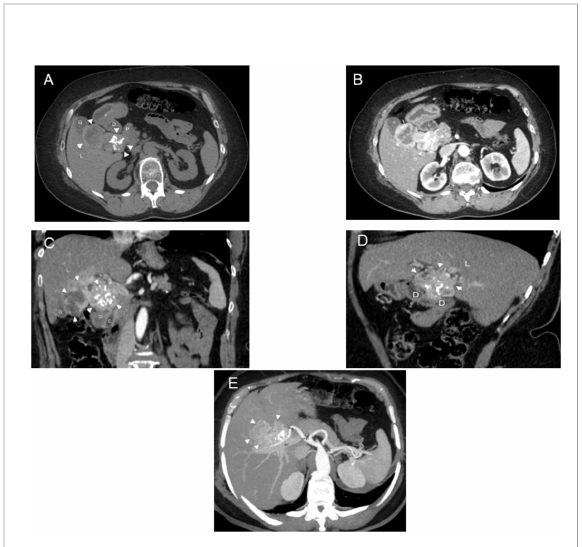
FIGURE 1 CT in a 65-year-old woman with ectopic thyroid in the hepatic hilum. (A) Unenhanced and (B) enhanced axial CT images. Dishomogeneous density and partially calci fi ed mass (arrowheads) can be observed in the right hypochondrium between the duodenum (D), liver (L), pancreas (P), and gallbladder (G). Dishomogeneous enhancement of the mass is appreciable in the arterial phase. (C) Enhanced coronal CT image. The mass (arrowheads) has a bilobated shape and occupies the hepatic hilum, between the liver (L), gallbladder (G), duodenum (D), pancreas (P), and choledoch (C). (D) Enhanced sagittal CT image. The mass (arrowheads) pushes downward the second portion of the duodenum (D), being interposed between it and the liver (L). (E) Axial 3D MIP. The mass (arrowheads) is supplied by a branch of the right hepatic artery (rha); cha, common hepatic artery; rpv, right portal